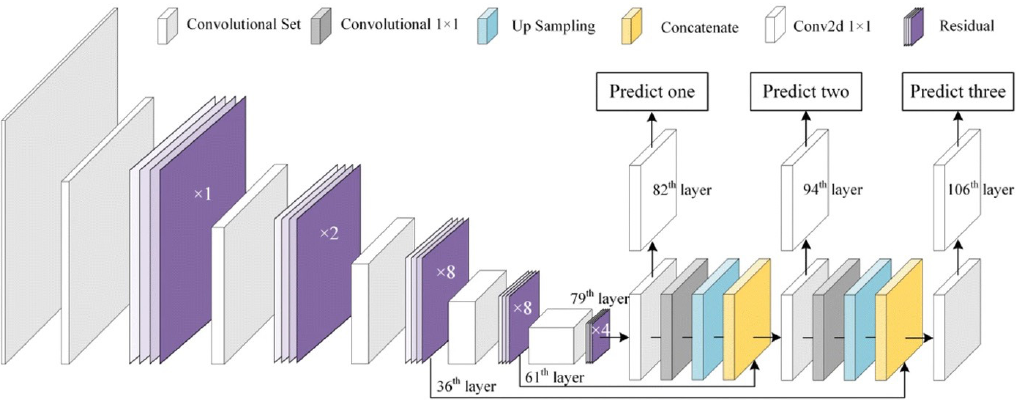
Figure 11. YOLOv3 neural network architecture.